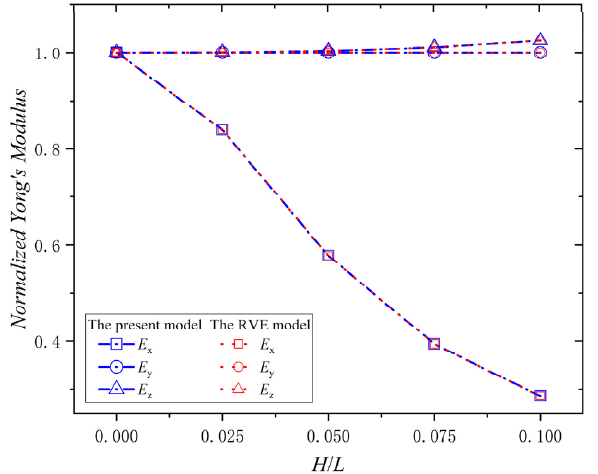
model and the RVE model increases with the increase of 𝐻/𝐿 . When 𝐻/𝐿 = 0.1, the increase percentage of 𝐺 (cid:2935)(cid:2936) in the present model is 4.5%, and that of the RVE model is 4.5%. The nor- crease of 𝐻/𝐿 . When 𝐻/𝐿 = 0.1, the increase percentage of 𝐺 (cid:2934)(cid:2936) in the present model is 25.4%,